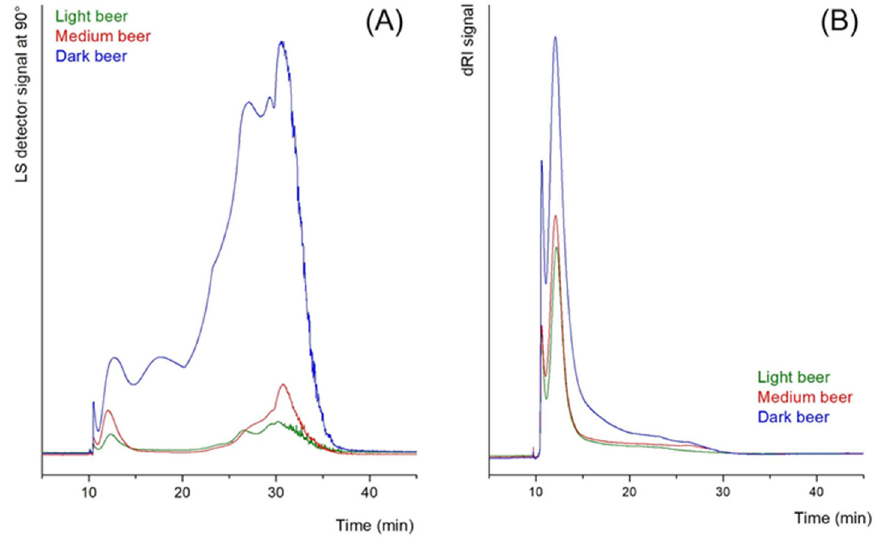
Figure 3. Elution profiles of the different beer samples (1:1 dilution, injection volume 50 µL): Light scattering at 90° ( A ) and dRI ( B ) signals.